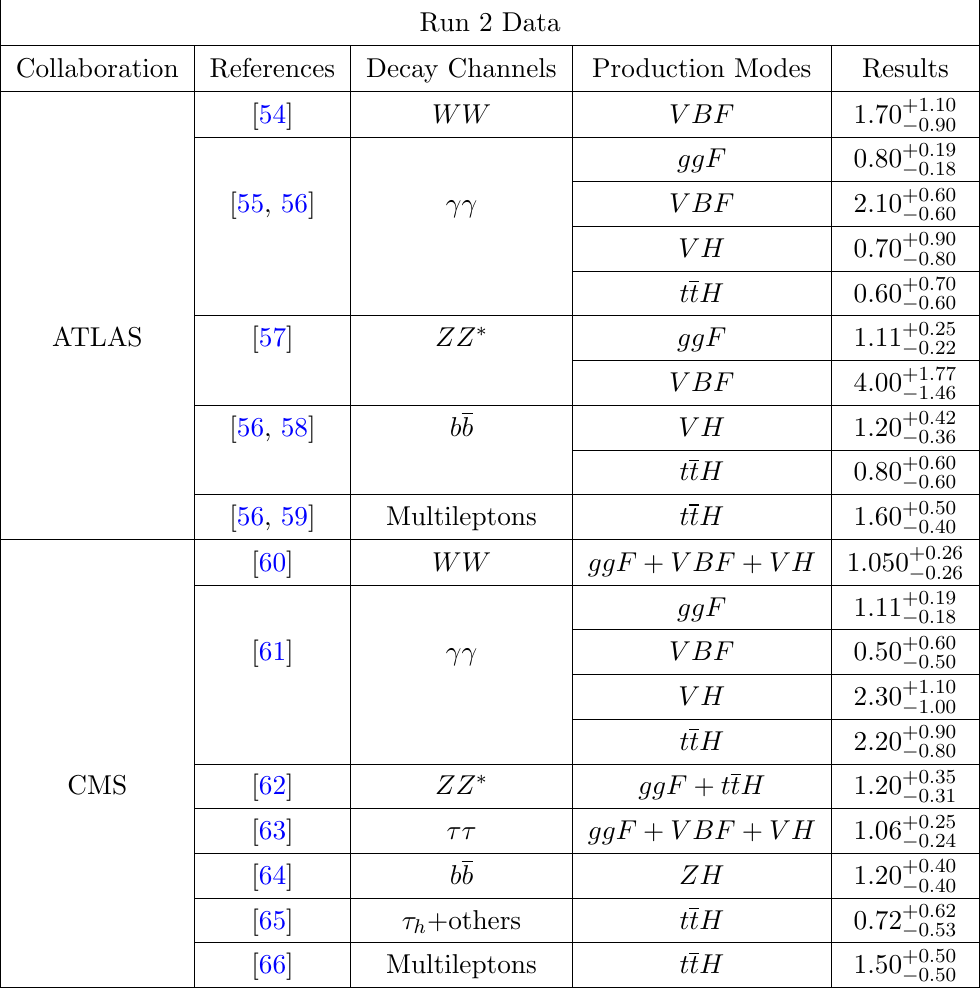
Table 3. Results from the ATLAS and CMS collaborations for Higgs signal strengths at 13 TeV are